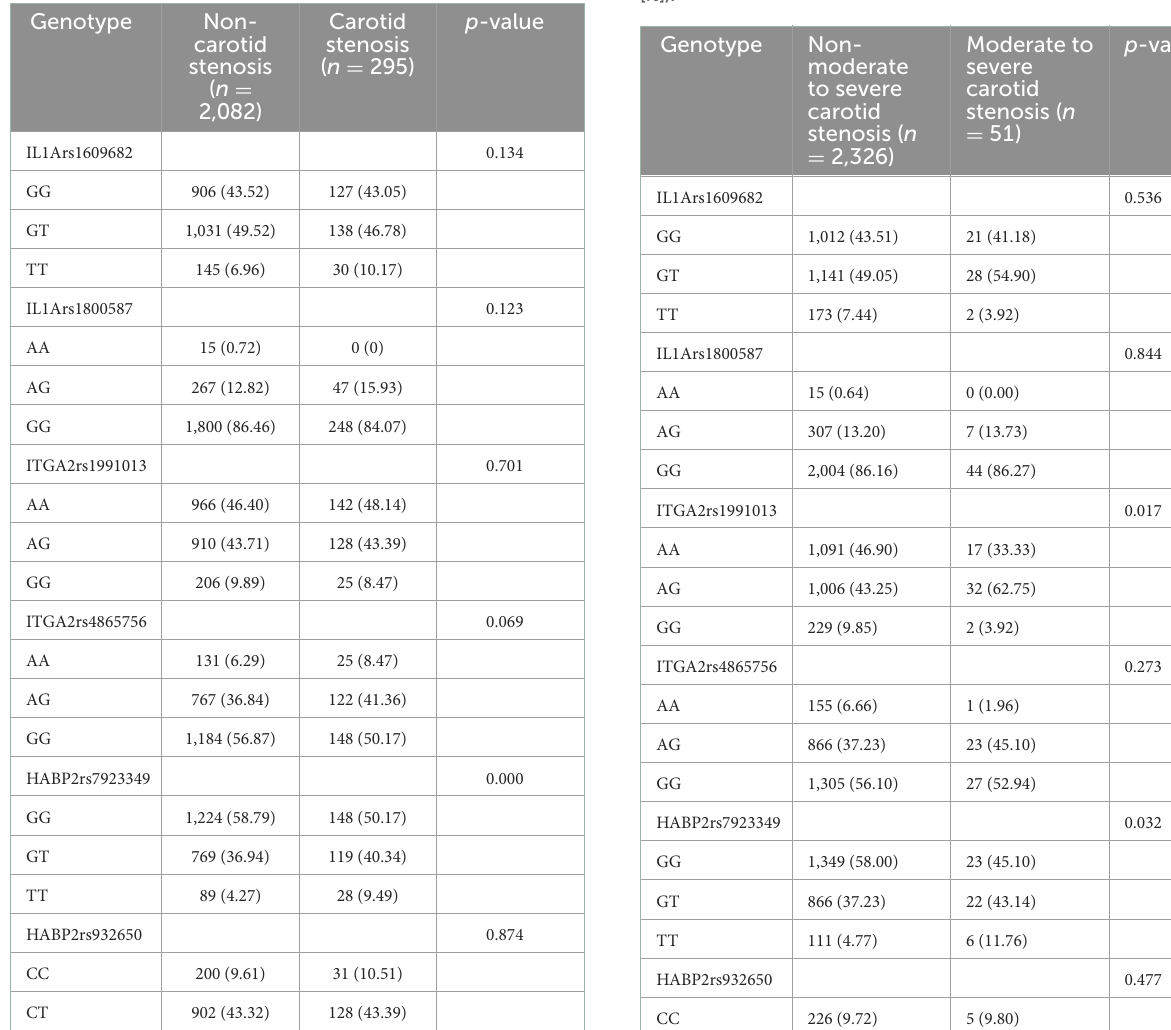
TABLE 2 Genotype distribution in individuals with and without carotid stenosis ( n [%]).